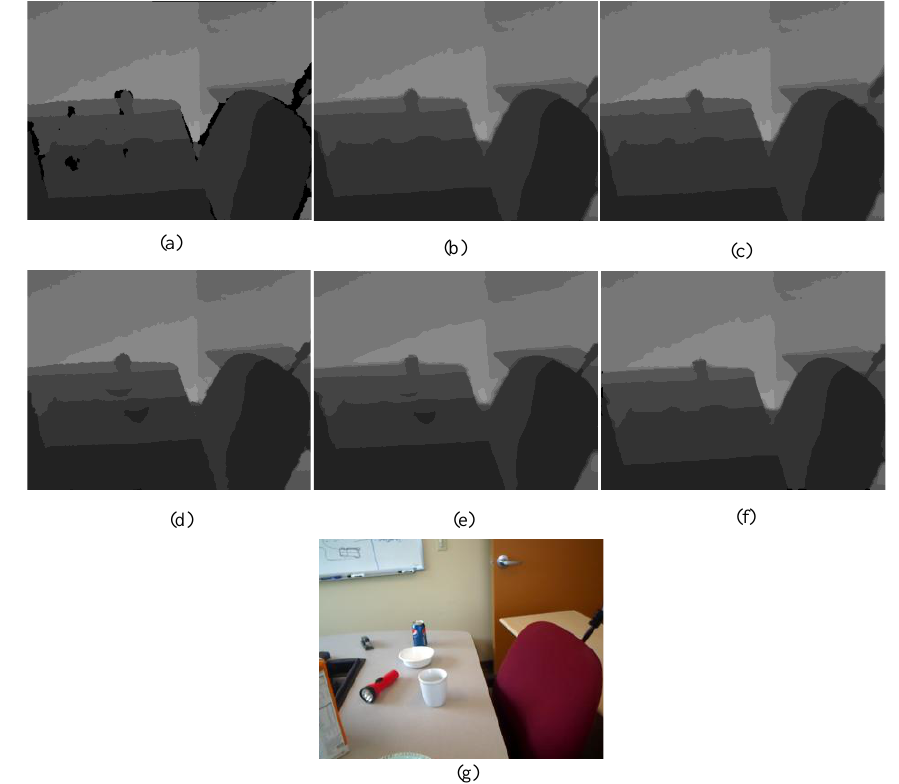
Figure 10. Experimental Results: ( a ) Original; ( b ) JBF; ( c ) FMI; ( d ) GFMI; ( e ) GFMIGF; ( f ) Proposed method; ( g ) Color image.